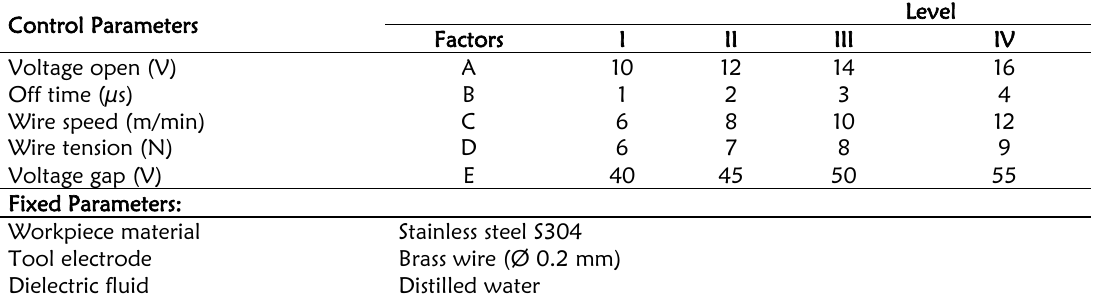
Table 1: Experimental parameters of WEDM